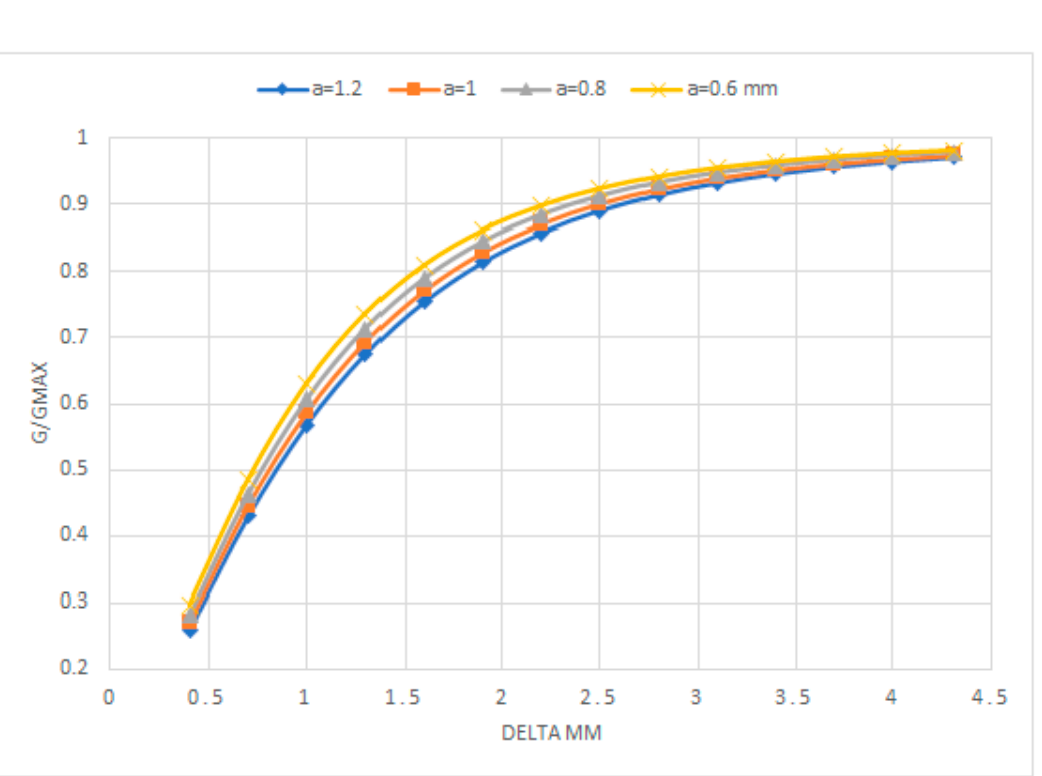
(cid:3008) versus (cid:2012) , for different distances between the electrodes . 2(cid:1853) = 1.2 mm,2(cid:1853) = Figure 12. G versus δ , for di ff erent distances between the electrodes. 2 a = 1.2 mm, 2 a = 1.6 mm, 2 a = (cid:3008) (cid:3288)(cid:3276)(cid:3299) G max 2 mm, and 2 a = 2.4 1.6 mm,2(cid:1853) = 2 mm, (cid:1853)(cid:1866)(cid:1856) 2(cid:1853) = 2.4 mm .